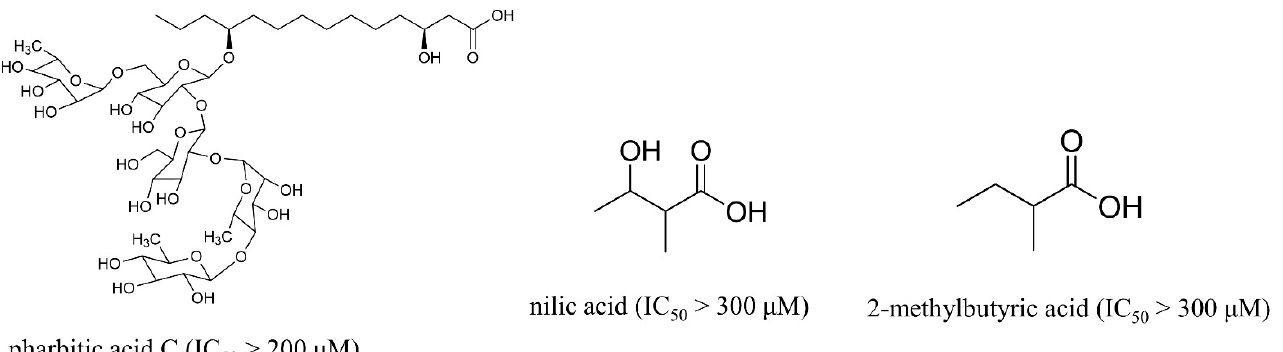
Figure 3. Chemical structures and anthelmintic activity of some pharbitin fragments.